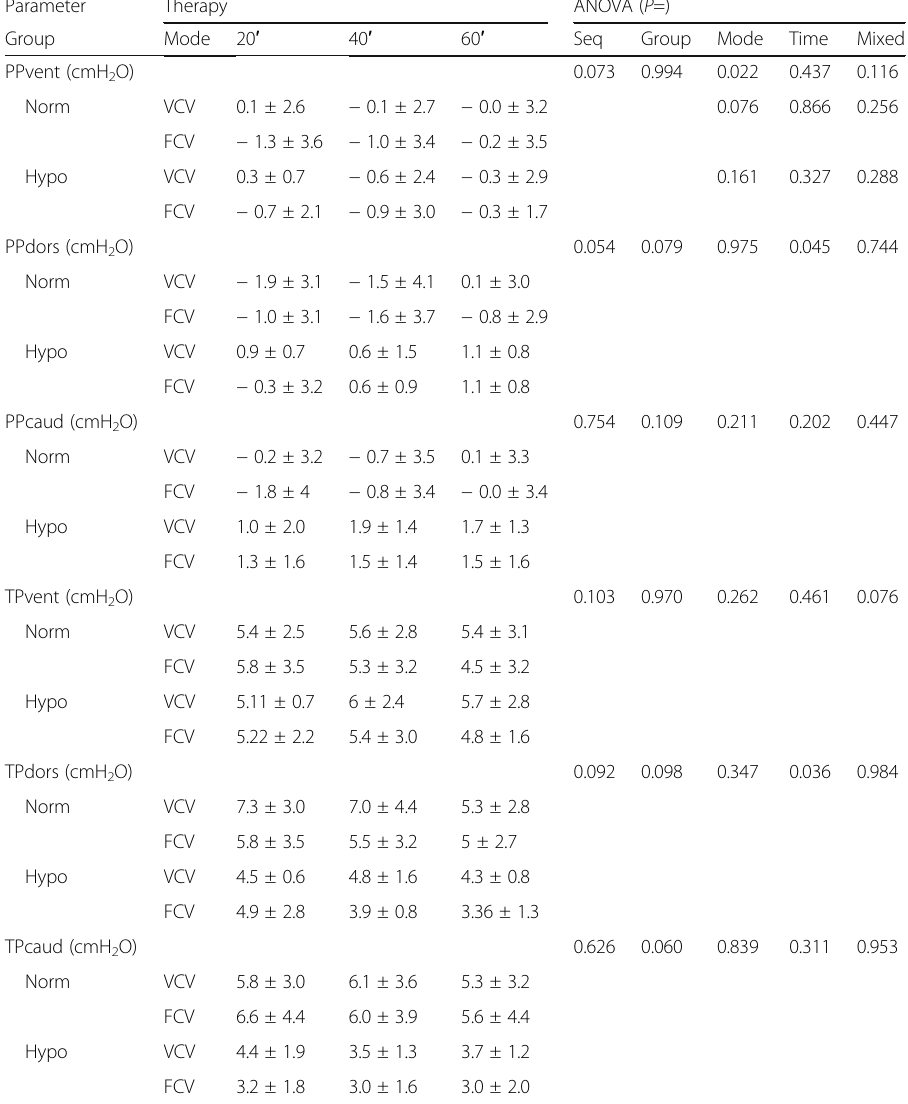
Table 4 Regional end-expiratory pleural and transpulmonary pressures Parameter Therapy ANOVA ( P =)